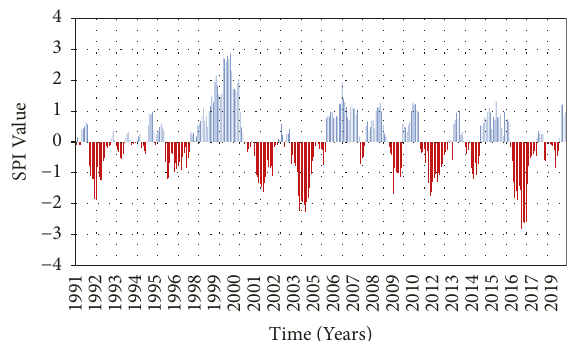
Figure 5: Temporal variation of SPI values for 29 years (1991–2019).